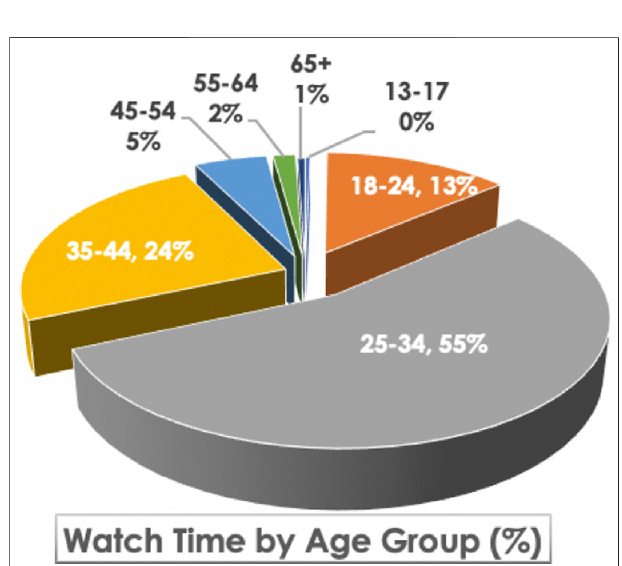
FIGURE 7 | Hand surgery international YouTube channel watch time by